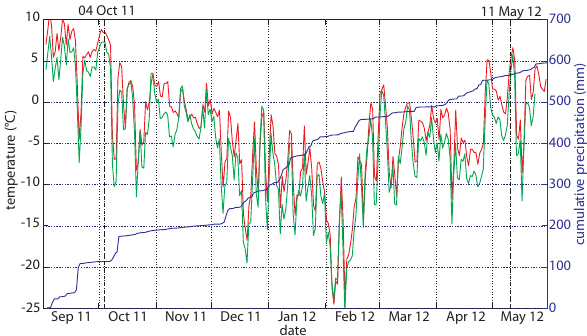
Fig. 4. Mean daily air temperature measured at the automatic weather station (AWS, Fig. 2) Hintereisferner (3027ma.s.l.; green curve) and the AWS Vernagtferner (2640ma.s.l.; red curve) for the accumulation season 2011/2012. Cumulative precipitation is shown for the AWS Vernagtferner (blue curve). Dates of ALS surveys are marked as dotted lines.